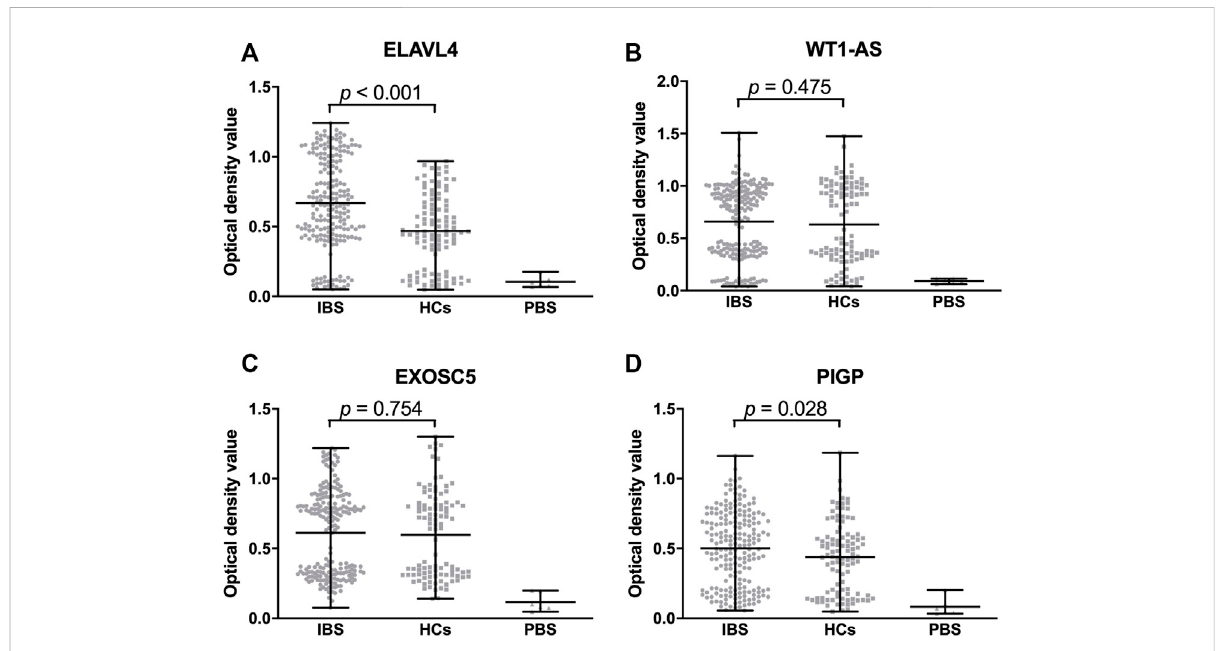
FIGURE 5 Comparison of optical density value of validated proteins among IBS patients, HCs and DCs. The optical density value of ELAVL4 (IgG) of IBS is signi fi cantly higher than HCs (A) . The optical density values of WT1-AS and EXOSC5 (IgG) are not signi fi cantly different between IBS and HCs (B,C) . TheopticaldensityvalueofPIGP(IgA)ofIBSissigni fi cantlyhigherthanHCs (D) .IBS,irritablebowelsyndrome;HCs,healthycontrols;PBS,phosphate buffered